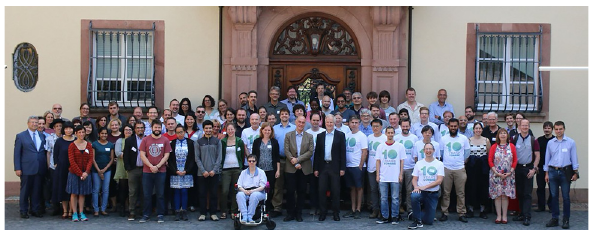
Figure 2: Participants of the 2019